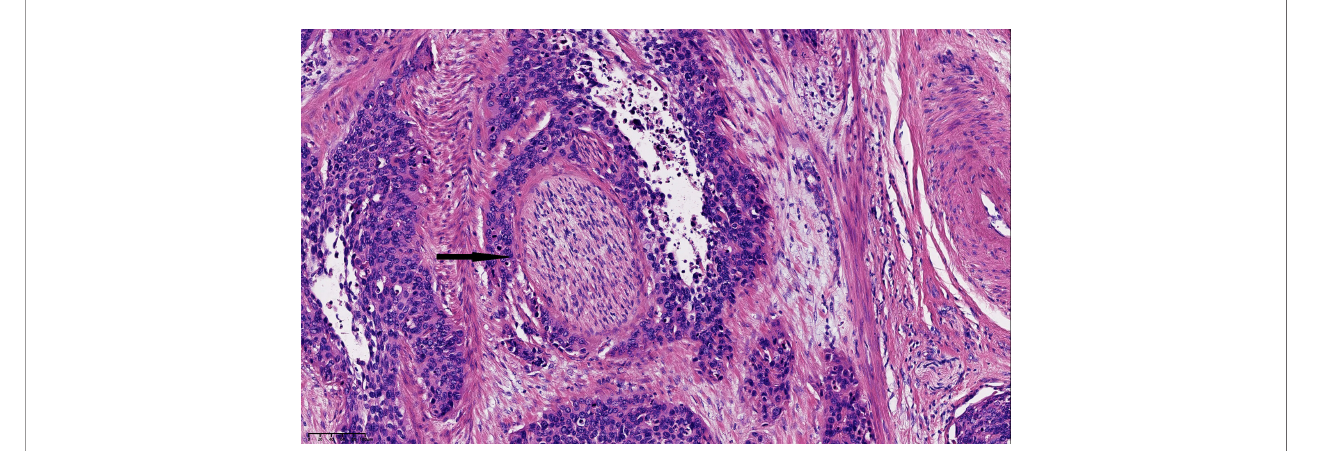
FIGURE 1 | Histological image of perineural invasion (PNI) in cervical squamous cell carcinoma stained with Hematoxylin and eosin (H&E). PNI from small cancer cell clusters is indicated by arrows (magni fi cation, x200). Scale bar: 20 m m each